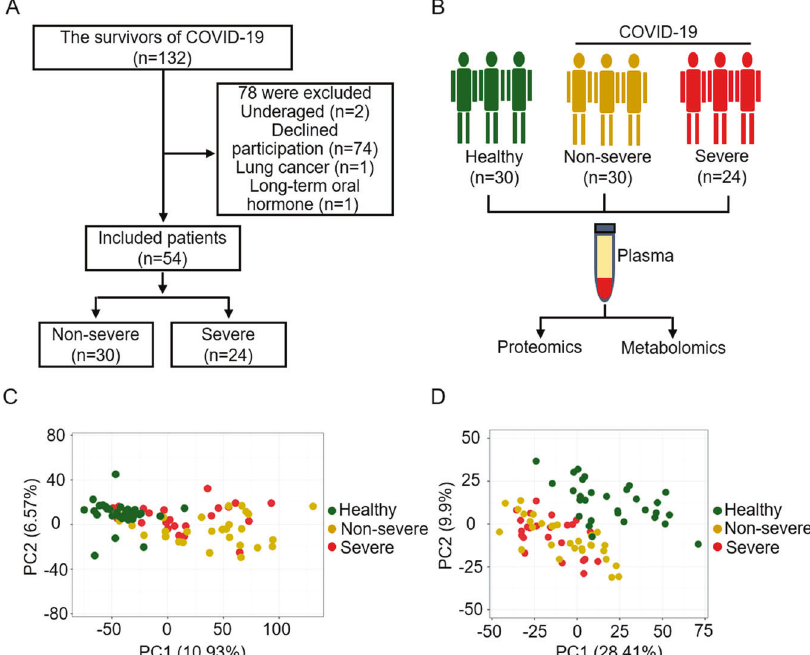
Fig. 1 Overview of the study design. A Flow chart of inclusion and exclusion for COVID-19 patients enrolled in this study. B Schematic summary of the study design and patient cohort. C PCA plot of the proteomics data from the plasma samples. Each dot represents one plasma sample, color-coded for the different groups. Green, yellow, and red data points are healthy control subjects and non-severe and severe COVID-19 survivors at 6 months after discharge, respectively. D PCA plot of the metabolomics data from the plasma samples. Each dot represents one plasma sample, color-coded for the different groups as described for panel ( C